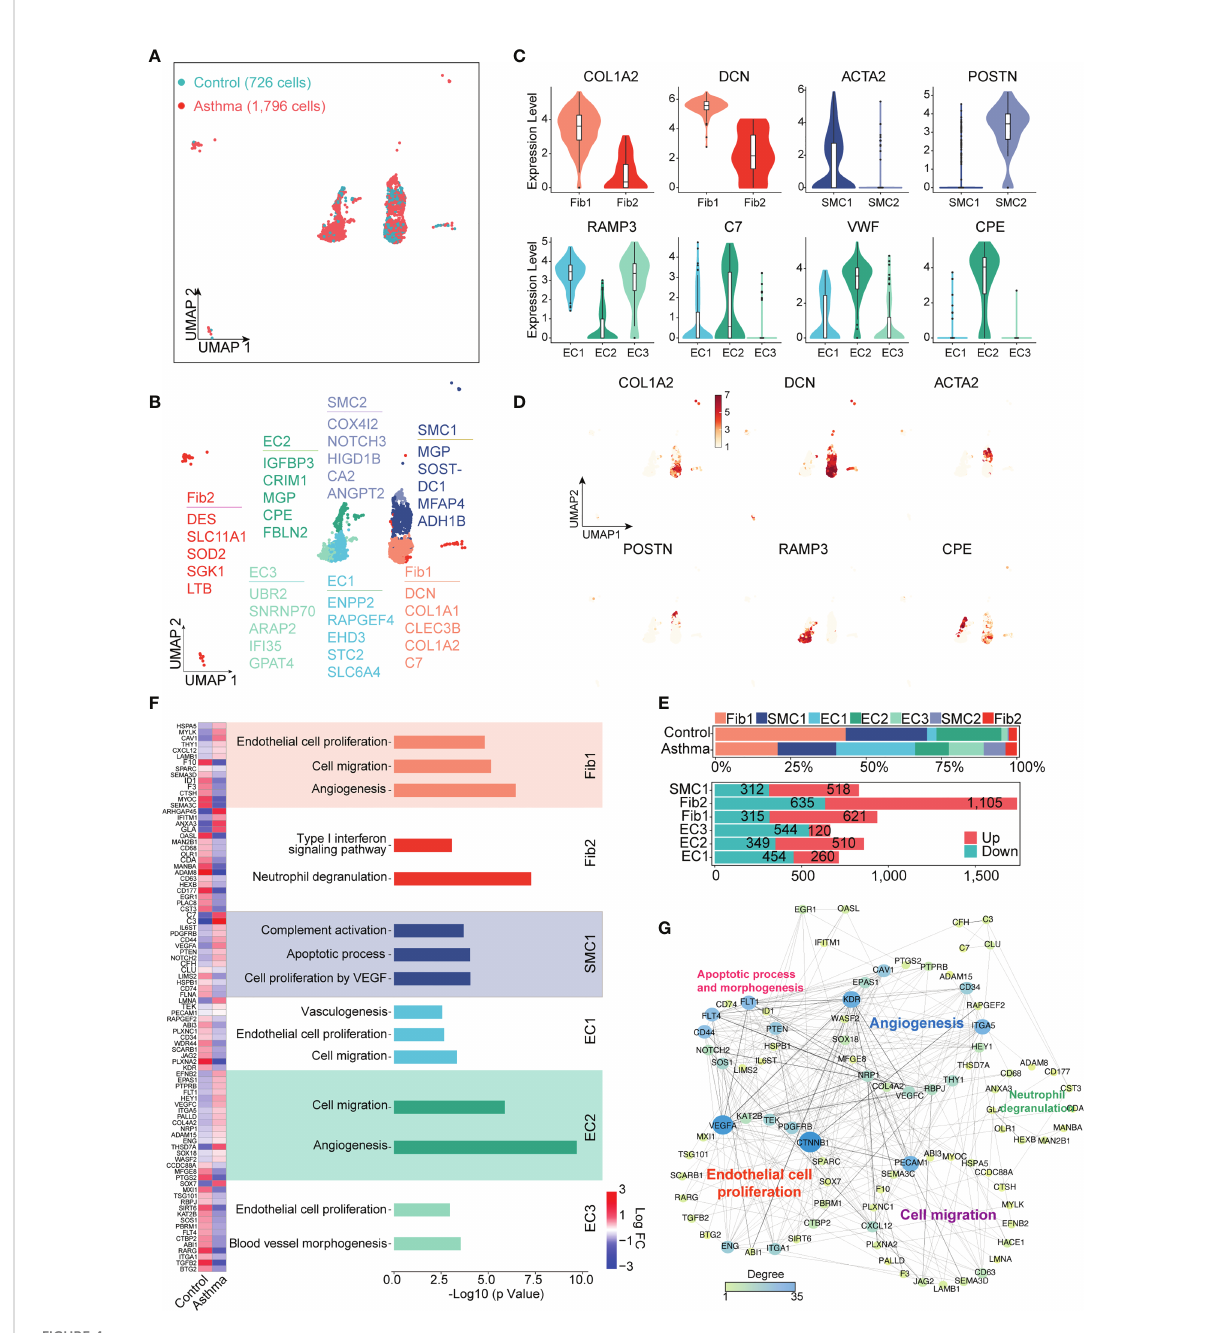
FIGURE 4 A.suum -induced asthma signi fi cantly elevates the numbers of ECs, Fibs and SMCs in the lungs of cynomolgus monkeys. (A) , UMAP visualization of all scRNA-seq data of stromal cells in the control and asthma groups. Captured cells: control = 726, asthma = 1,796. (B) , Seven clusters (subtypes) of stromal cells are colored and labeled according to their inferred cell type identities. (C) , Violin plots assessment of signature gene expression in each subtype. (D) , UMAP visualization of unique gene expression speci fi cally distinguishes each cluster Fib1 (COL1A2), Fib1 and Fib2 (DCN), SMC1 (ACTA2), SMC2 (POSTIN), EC1 and EC3 (RAMP3) and EC2 (CPE). (E) , Representation of the cell numbers proportion and DEG numbers of control and asthma in each subtype. (F) , Representation of signi fi cant GO and KEGG analysis associated with and heatmap showing the differential genes in biological processes between the control and asthma group. (G) , Visualization of gene regulatory network analysis between cell subsets. Interactions between genes are shown as edges. Node sizes and shades of color re fl ect the degree of centrality and strength of